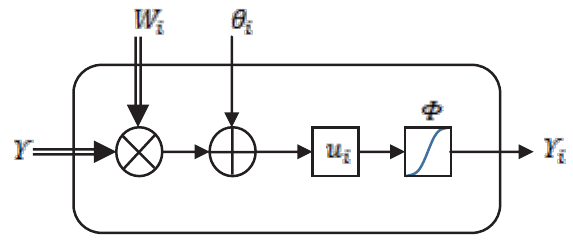
Fig. 6 Elementary nonlinear processing neuron